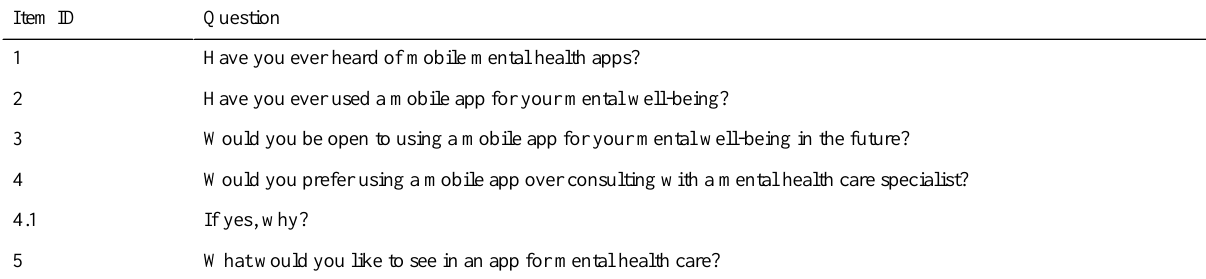
Table 3. Questions in Part 2 of the questionnaire related to mental health care apps. QuestionItem